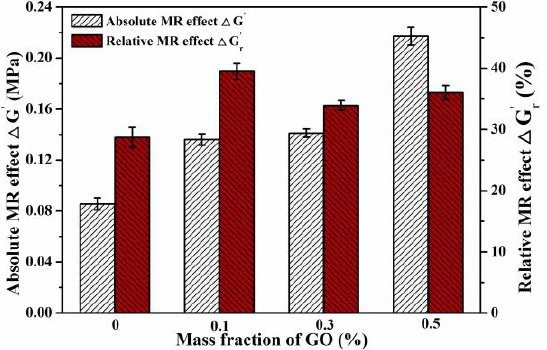
Figure 13. The absolute and relative MR effect of the MREs under dynamic shear loads.